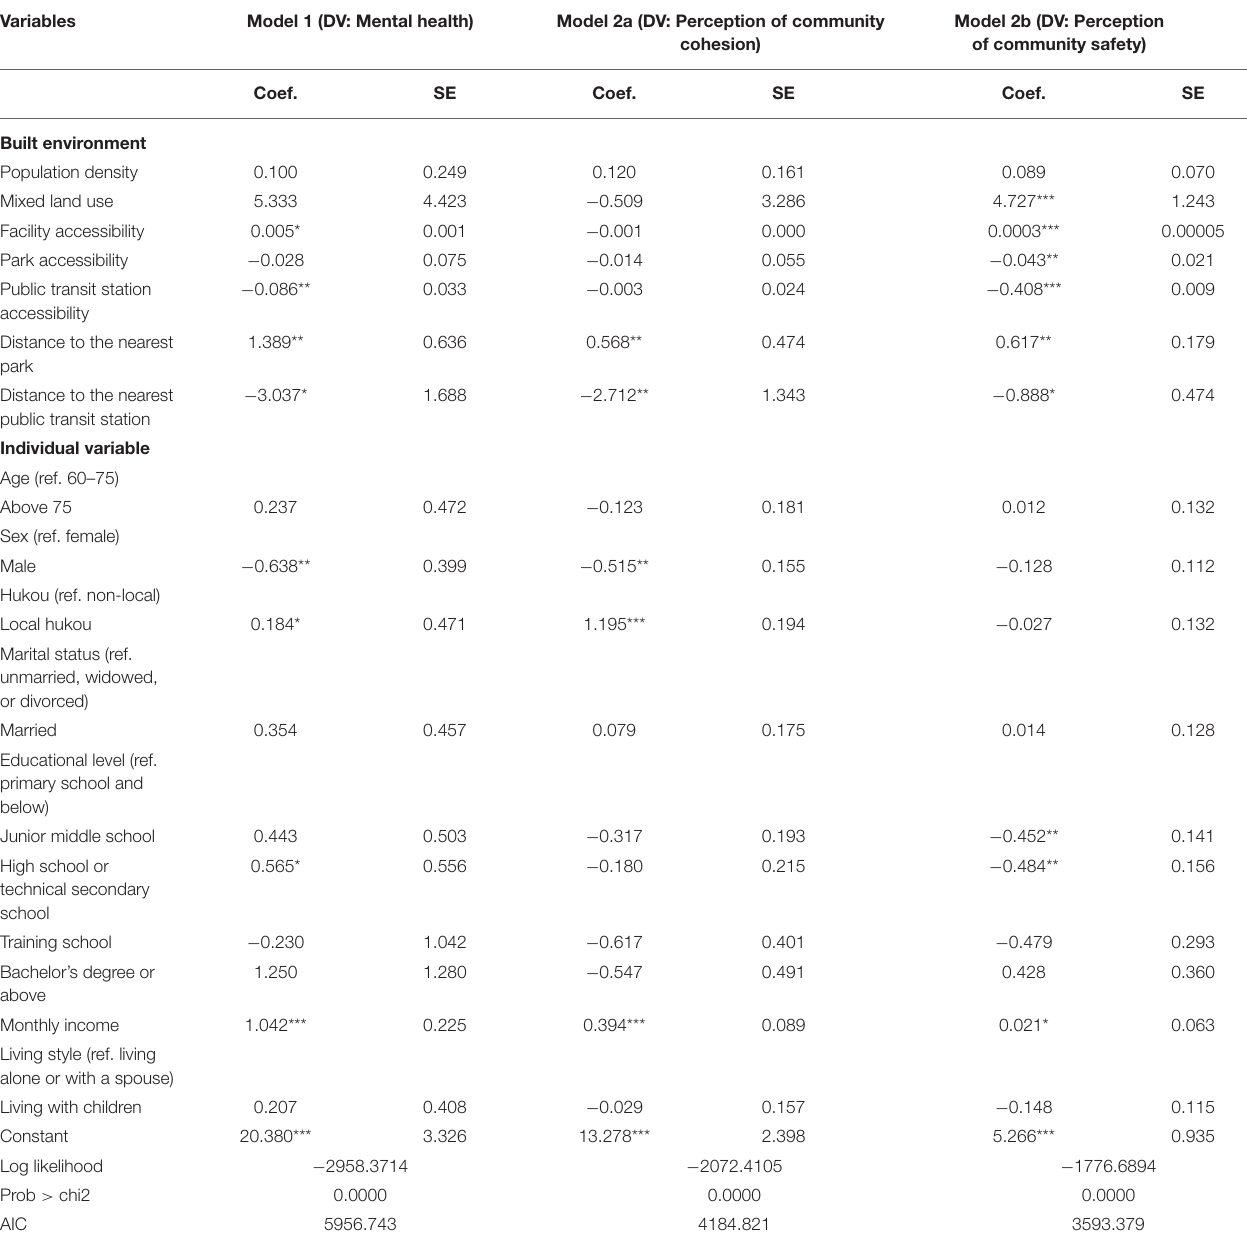
TABLE 4 | Relationship between built environment, perception of community cohesion, perception of community safety, and mental health. Variables Model 1 (DV: Mental health) Model 2a (DV: Perception of community